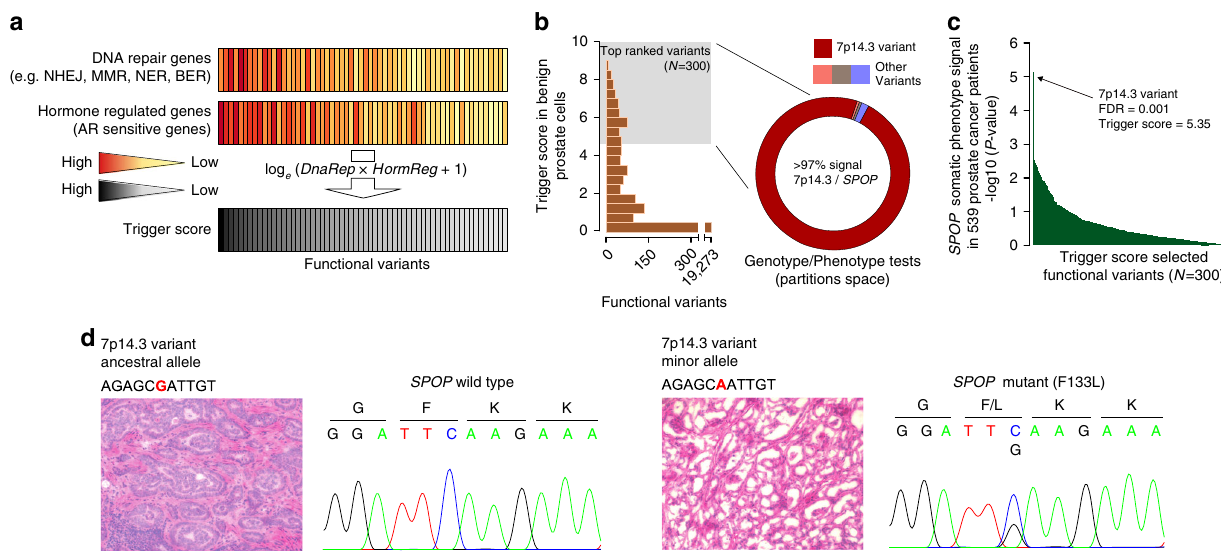
Fig. 1 Genetic predisposition to SPOP mutant prostate cancer. a Schematic representation of the trigger score computation. The number of DNA repair ( DnaRep ) and hormone-regulated genes ( HormReg ) from healthy prostate cells that are modulated by a functional variant are combined into a ranking score that measures the likelihood to observe a prostate-speci fi c early somatic event. The combination of the two variables demonstrate the nontrivial impact that DNA repair and hormone-regulated genes have on trigger score ranking. b Trigger score distribution ( left ) across all considered functional variants; top ranked variants are highlighted. Genotype/phenotype analysis ( right ) is performed on random partitions of the data set into discovery and validation sets for three early recurrent prostate cancer lesions ( SPOP mutations, FOXA1 mutations, and TMPRSS2-ERG rearrangement). An 7p14.3 variant associated to SPOP was implicated in 97.4% of all collected associations (187 of the 192 partitions for which association signal was detected, red portion of the ring plot). No variants in the partition space for FOXA1 and TMPRSS2-ERG lesions were identi fi ed. c Genotype/ SPOP phenotype data on the whole study set is shown (7p14.3 variant highlighted, dominant test considered). d Hematoxylin and eosin stained prostate cancer frozen tissue sections and corresponding SPOP Sanger sequencing are shown for a patient carrying the 7p14.3 variant ancestral genotype and lacking SPOP mutation ( left ) and